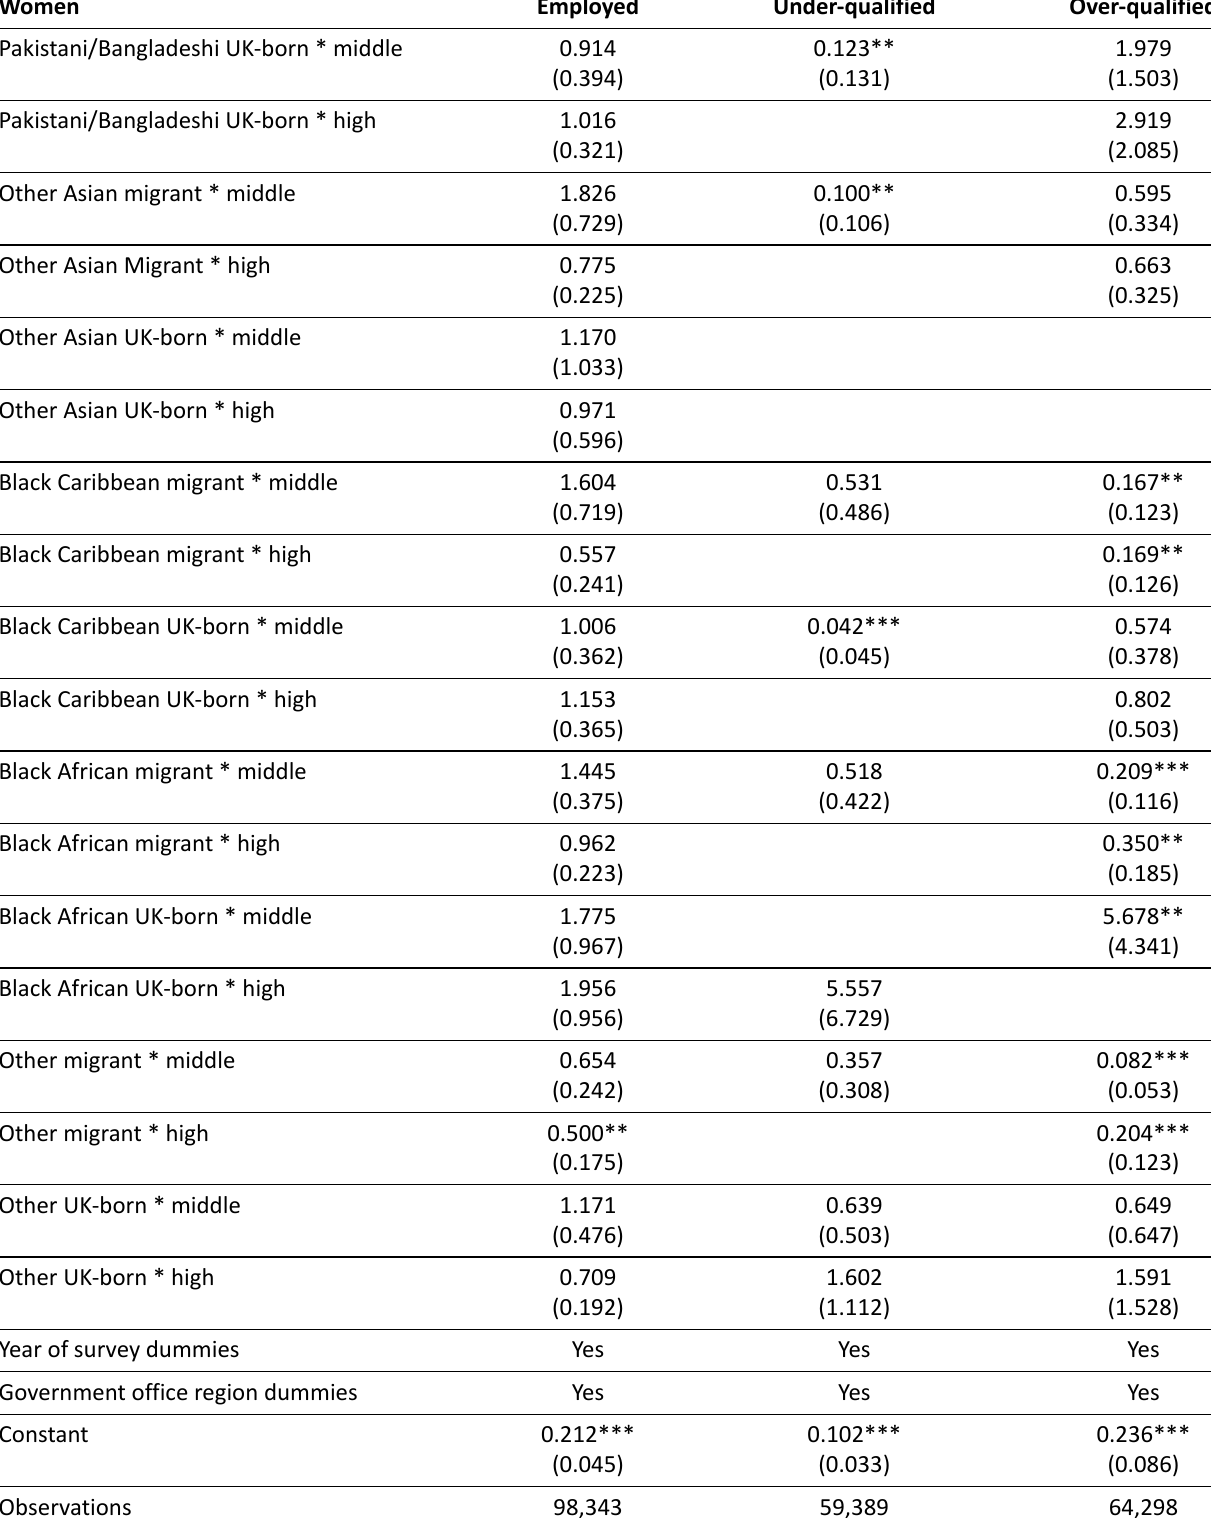
Table A4. (Cont.) Binary logistic regression model (odds ratio) of employment, under- and over-qualification for